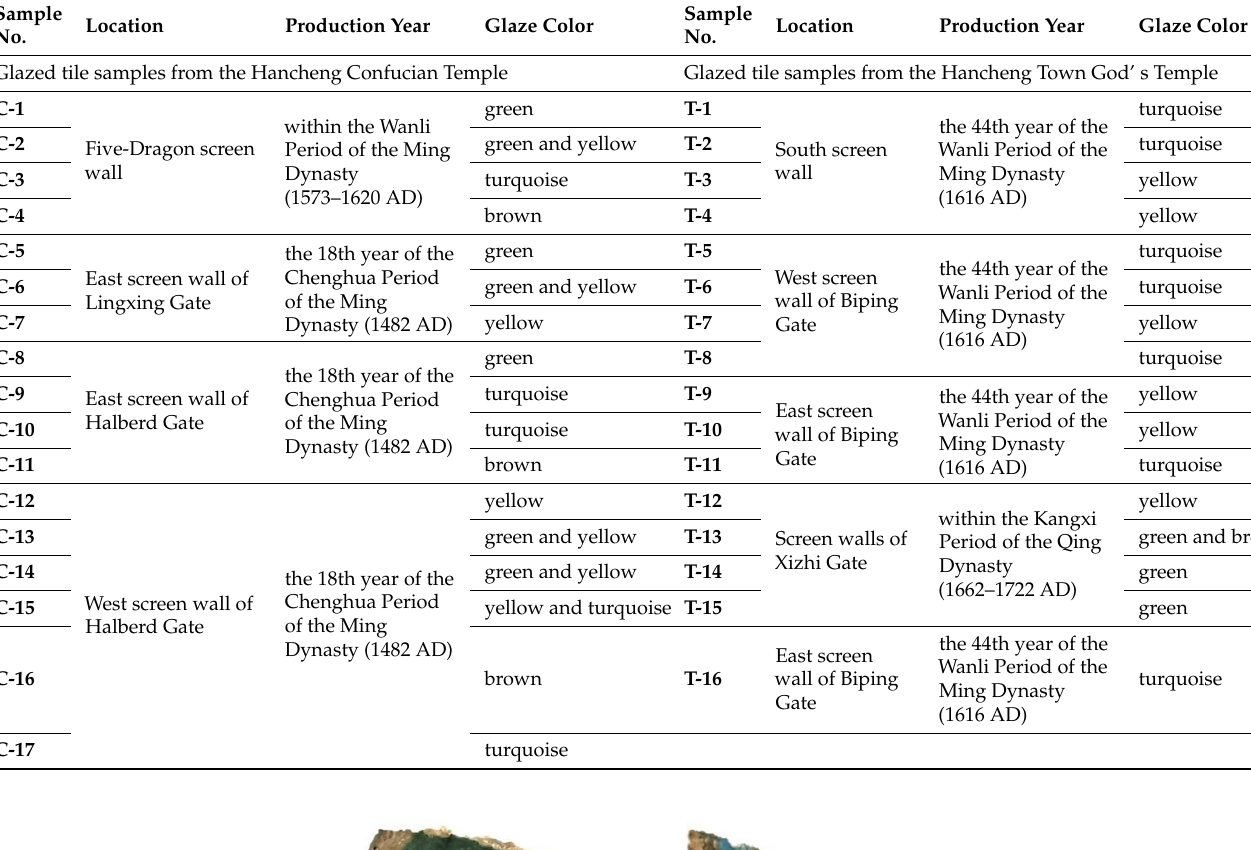
Table 1. The appearances of some typical samples are shown in Figure 5. Table 1. Sample information . Table 1. Sample information.